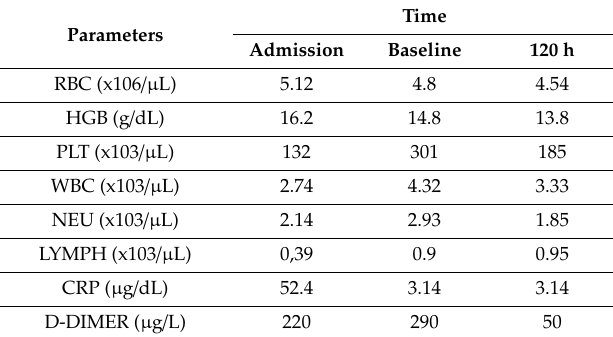
Table 1. Biochemical Parameters.